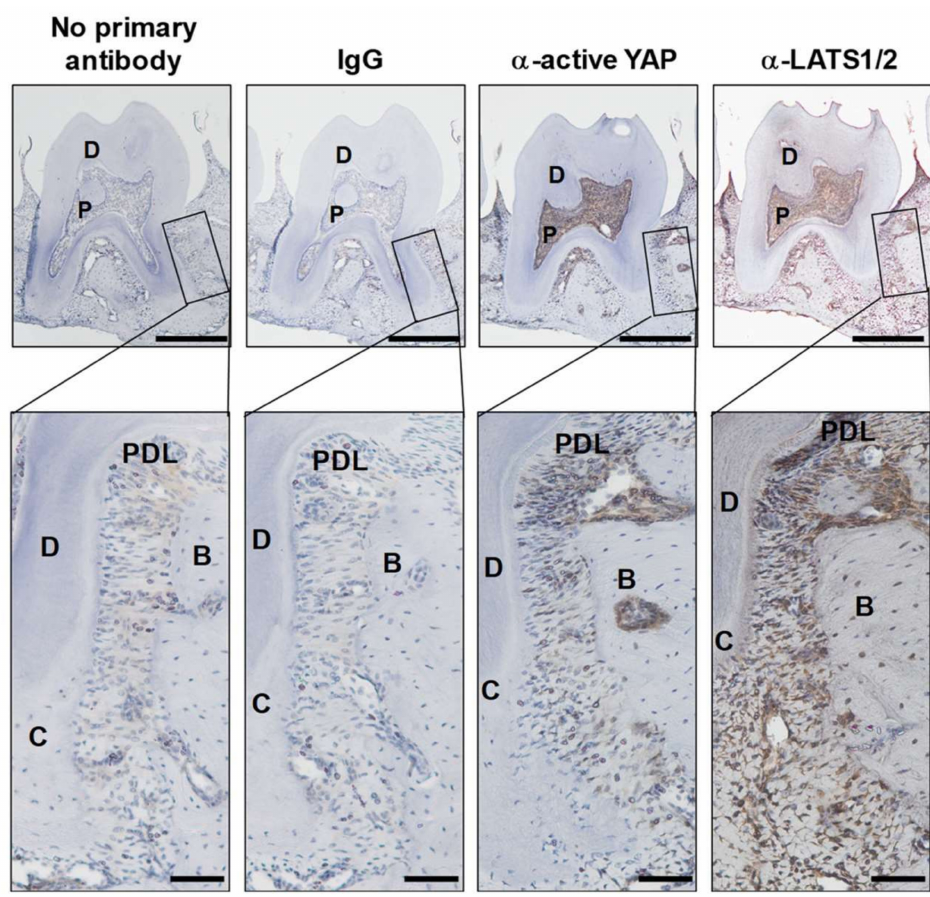
Figure 3. Active YAP and LATS1/2 expression in periodontal ligament tissue. Demineralized 3- month-old male maxilla sections were stained with or without rabbit IgG, or α -active YAP and α -LATS/12. Scale bars correspond to 500 and 100 µ m at low and high magnification, respectively. PDL = periodontal ligament tissue, C = cementum, D = dentin, B = bone, P =